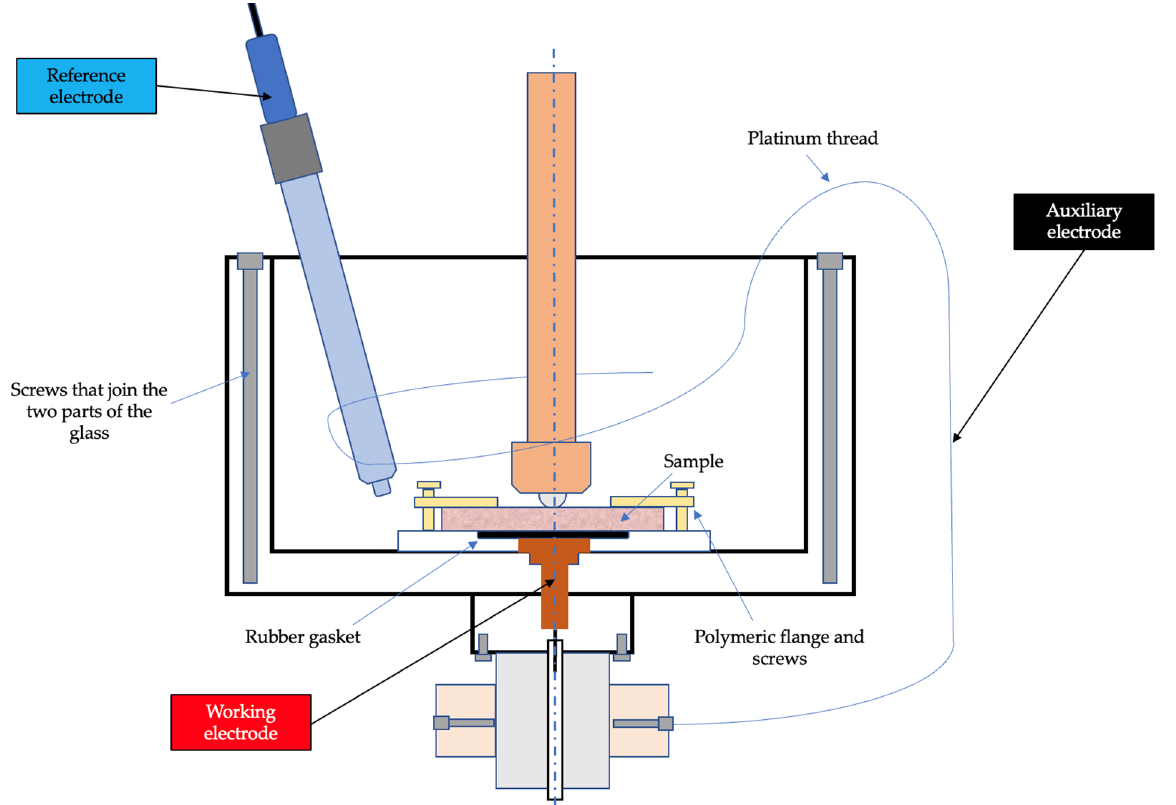
Figure 2. Set-up of the tribocorrosion tests performed combining pin-on-disk and potentiodynamic polarization tests.